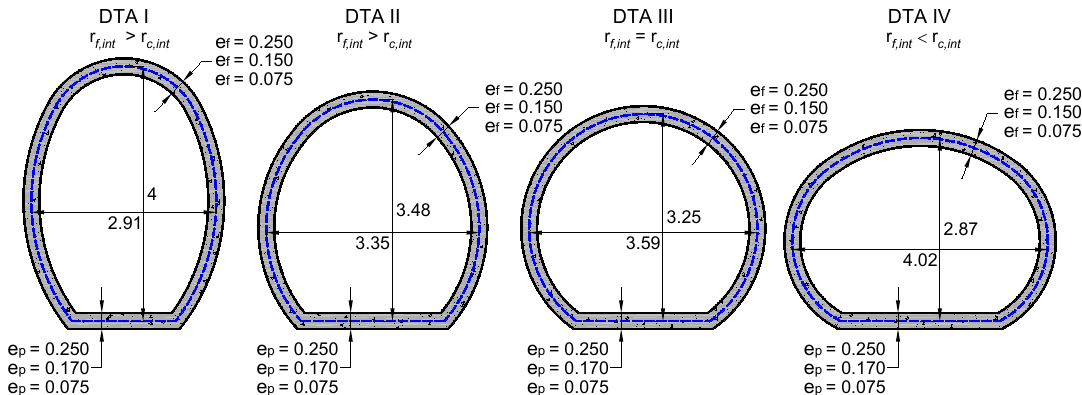
Figure 6. Representation of the cross section of the culvert defined by three arches.